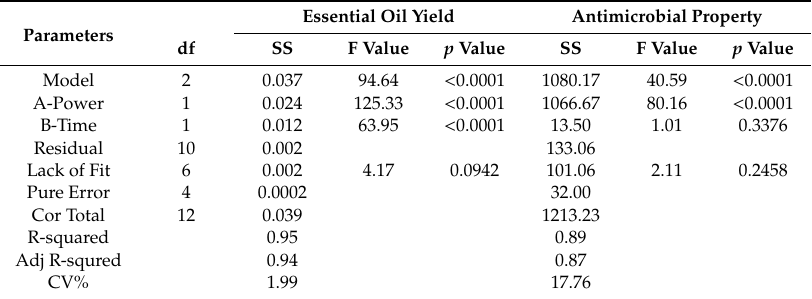
Table 2. ANOVA for essential oil yield and antimicrobial